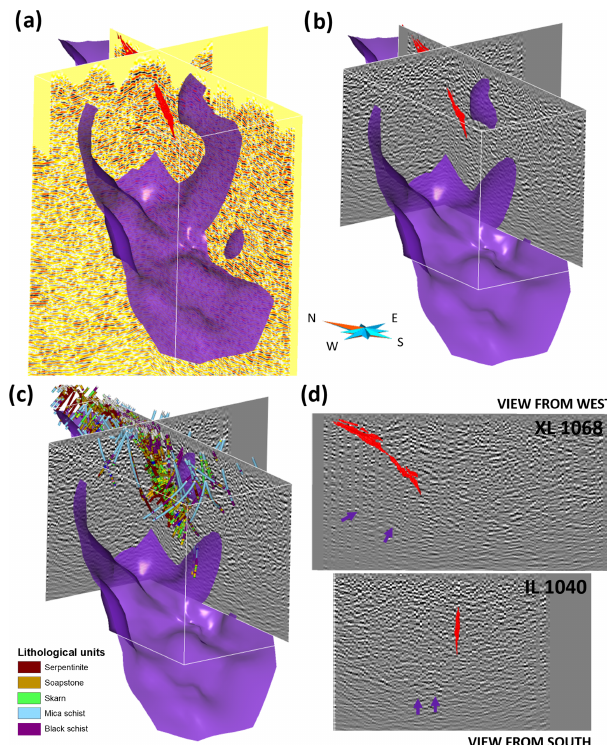
Figure 10. (a) The Kylylahti active-source 3D data processed with a similar 3D reflection seismic processing workflow as the passive 3D 10d subset data shown in (b) and overlapping the crossline 1068 and inline 1040 of the passive 3D cube in (b) . The pur- ple surface is the base of the Kylylahti formation interpreted from the COGITO-MIN 2D and 3D active-source data and the available borehole data (c) . The red surface is the Kylylahti semi-massive to massive sulfide mineralization. (d) Reflection signals associated with the base of the Kylylahti formation on the crossline 1068 and inline 1040 of the passive 3D cube highlighted with purple